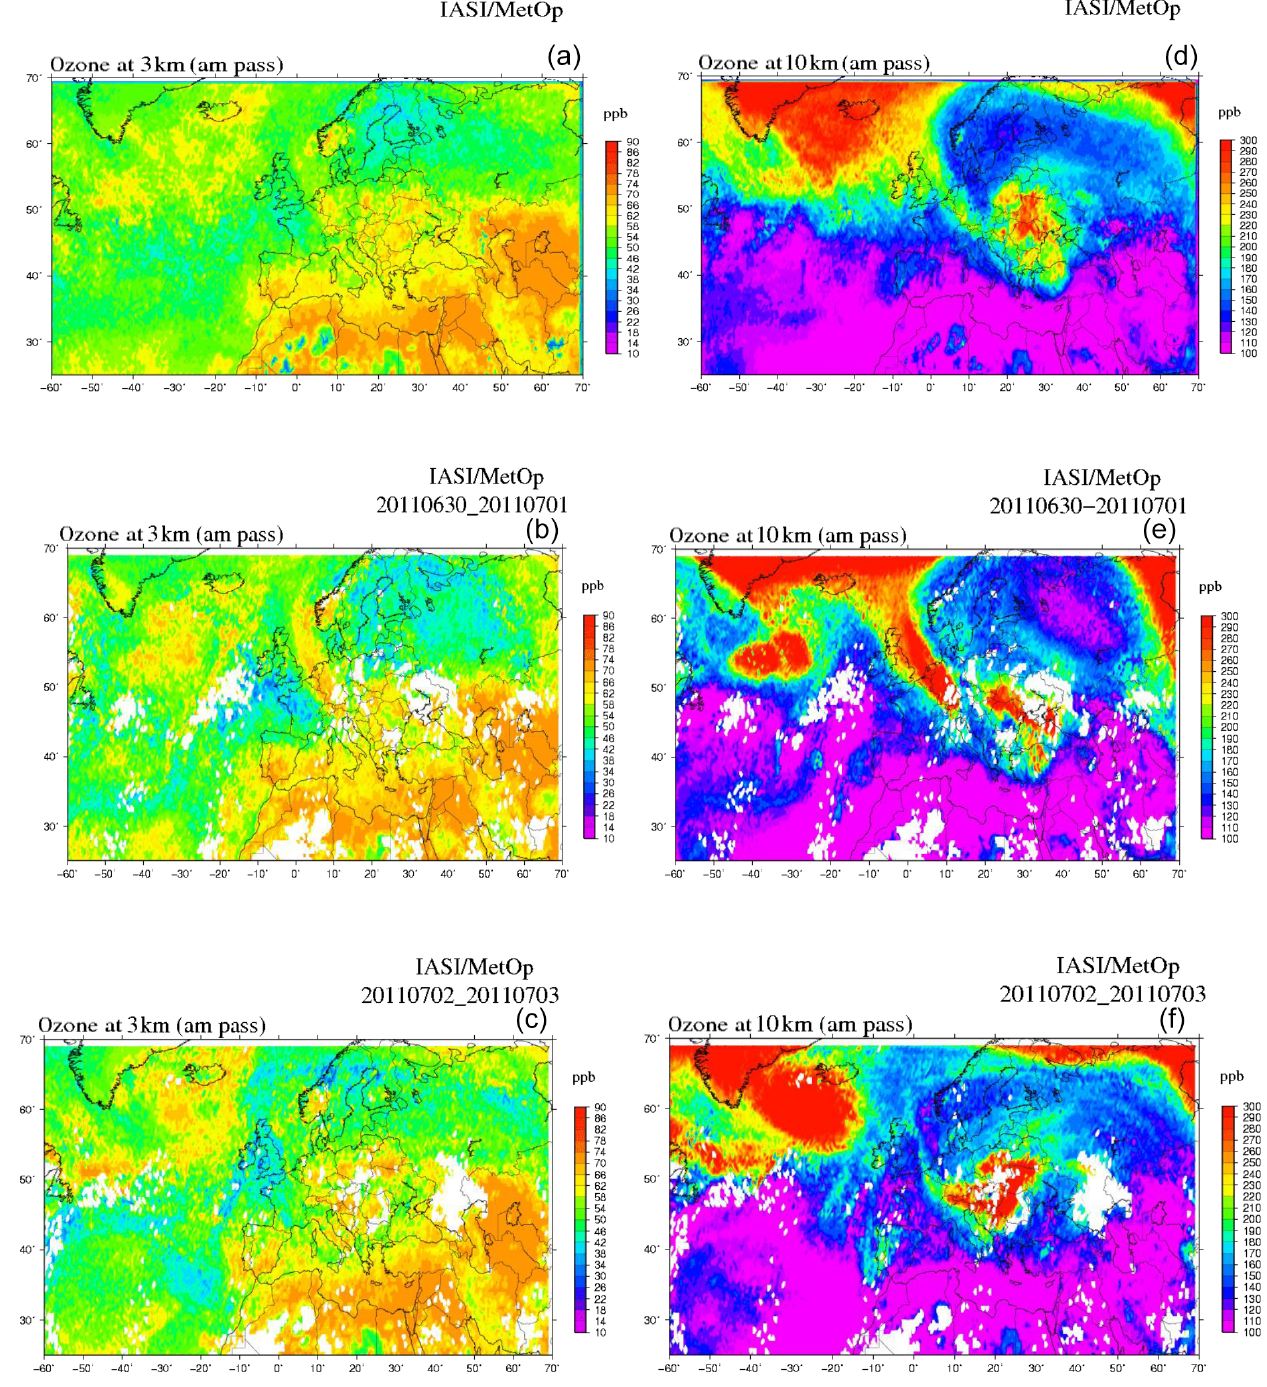
Figure 9. IASI satellite images of ozone concentration at 3km (a, b, c) and 10km (d, e, f) for the episode of 28 June–4 July 2011. Starting from the top: 28 June–4 July, 30 June–1 July and 2 July–3